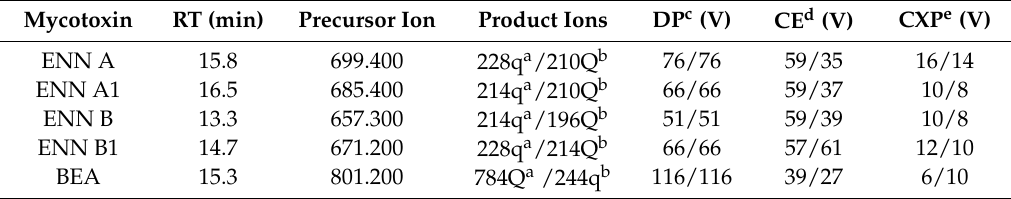
Table 1. The optimized MS/MS Parameters.